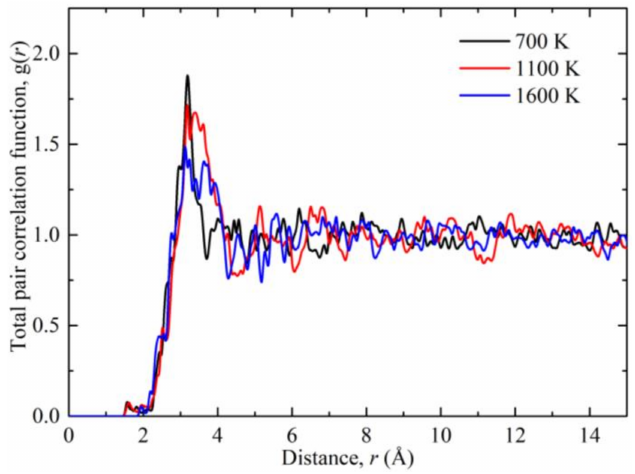
Figure 1. Total pair correlation function of liquid sodium at different temperature